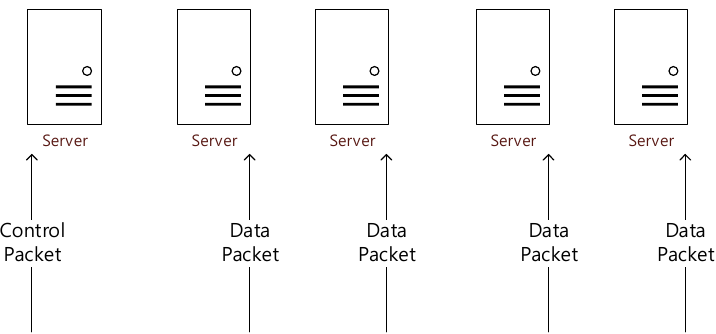
Figure 11. Example of a rated static partition environment by a 2:8 ratios.